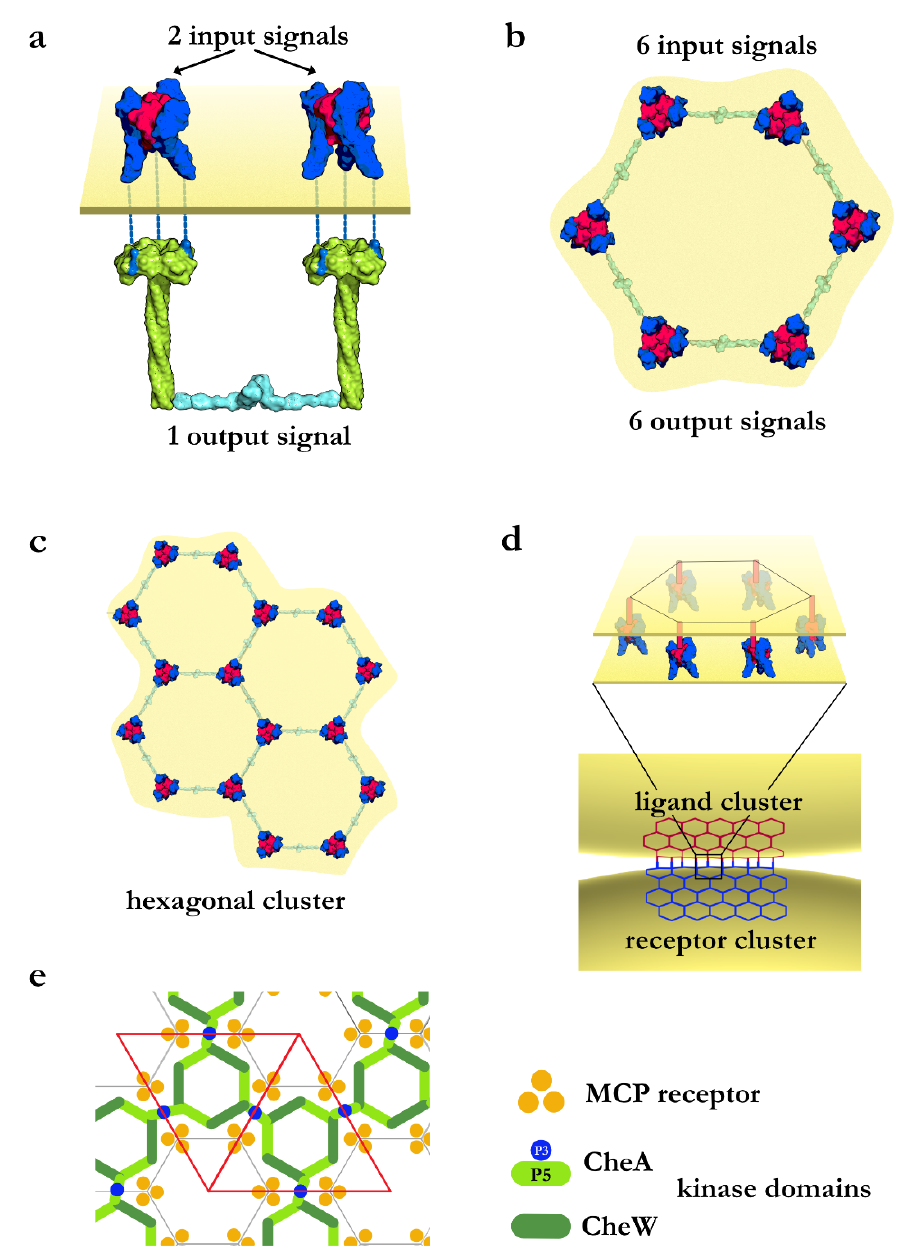
Figure 1. Illustration of cooperative biological signaling systems. ( a ) The TNF/TNFR2/TRAF signaling complex. The input signal is represented by TNF ligand (magenta) binding to TNFR2 (blue). Receptor activation initiates TRAF2 (green) recruitment and dimerization via the TRAF2 N-terminal RING domains (cyan) that represents the output signal. Connecting two signaling units introduces cooperativity, but the overall output signal is only half of the original input signals. ( b ) When six signaling units are connected in a hexagon (top view), the strength of the input signal can be maintained. ( c ) The hexagonal unit can further cluster into an ordered hexagonal signaling network. ( d ) In cell-to-cell interactions, clustered ligands attached to the membrane allow the simultaneous activation of clustered receptors with the same geometry, resulting in maximum signaling efficiency. ( e ) Chemotaxis MCP receptor baseplate. The MCP receptor trimers are connected by the CheA kinase dimers (blue) to introduce cooperativity. The triangular unit cell is shown in